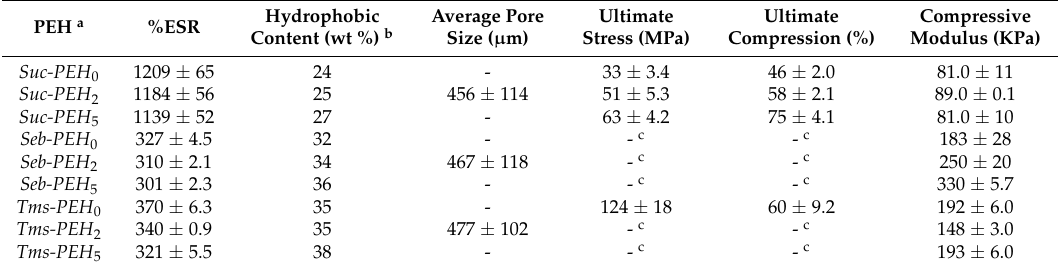
Table 2. Percentage equilibrium swelling ratio (%ESR), weight percentage of hydrophobic content, average pore size and mechanical characteristics (under compression testing) for the